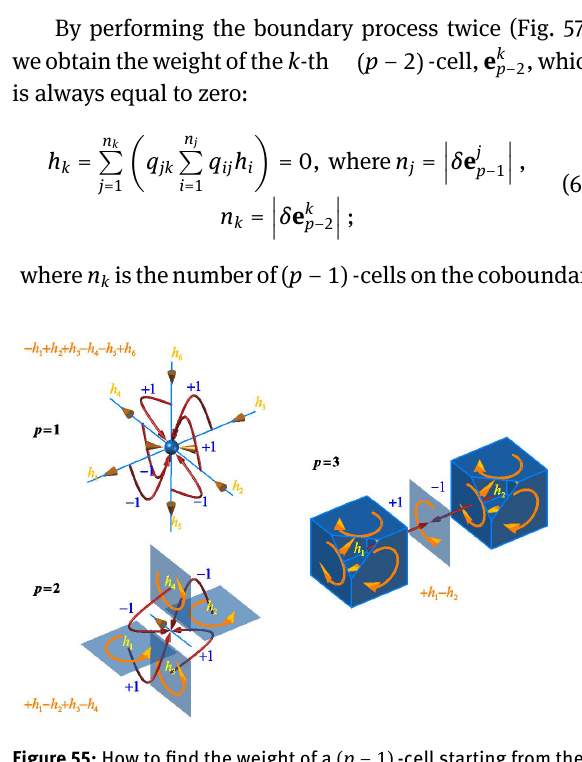
Figure 55: How to find the weight of a ( p − 1) -cell starting from the weights of its cofaces.